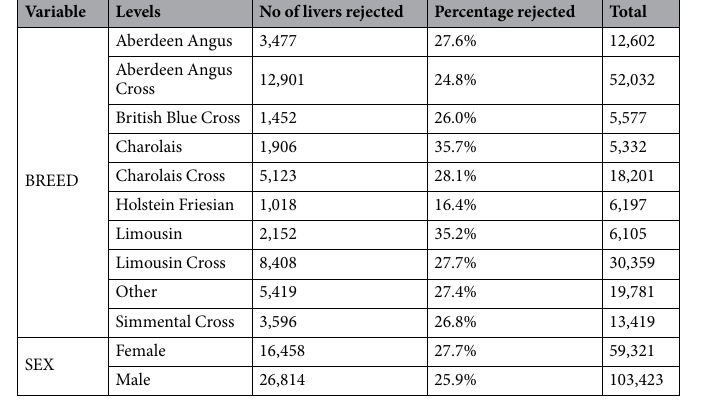
Table 1. Distribution of animals with livers rejected due to liver fluke, across the different breeds and across the sex of the animals.